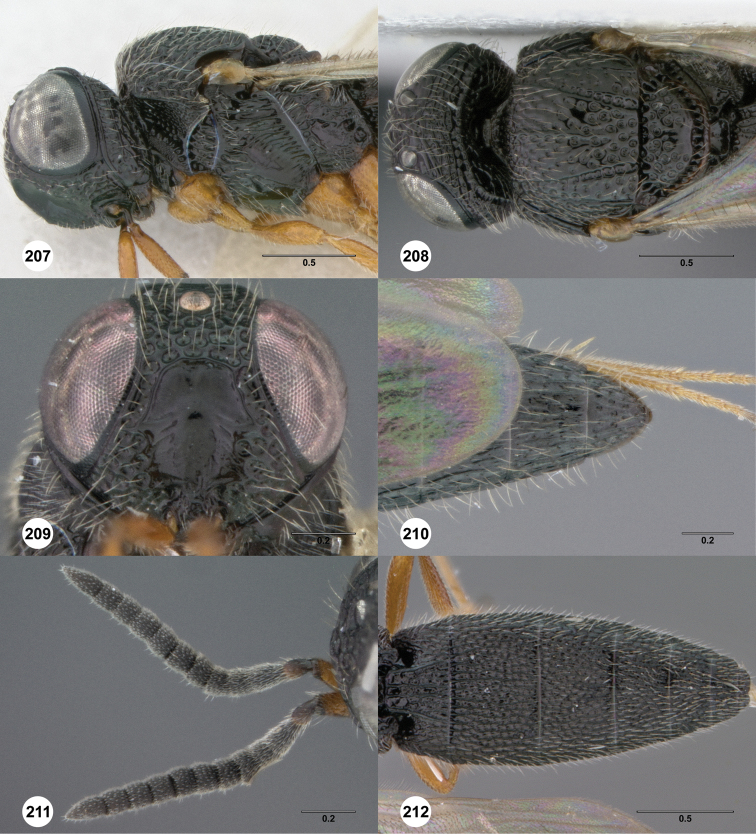
Oxyscelio nigriclava (Dodd), female (OSUC 441383) 207 Head and mesosoma, lateral view 208 Head and mesosoma, dorsal view. Female (OSUC 441384) 209 Head, anterior view. Female (OSUC 148370) 210 Metasoma, dorsal view. Male (OSUC 441386) 211 Antenna 212 Metasoma, dorsal view. Morphbank68